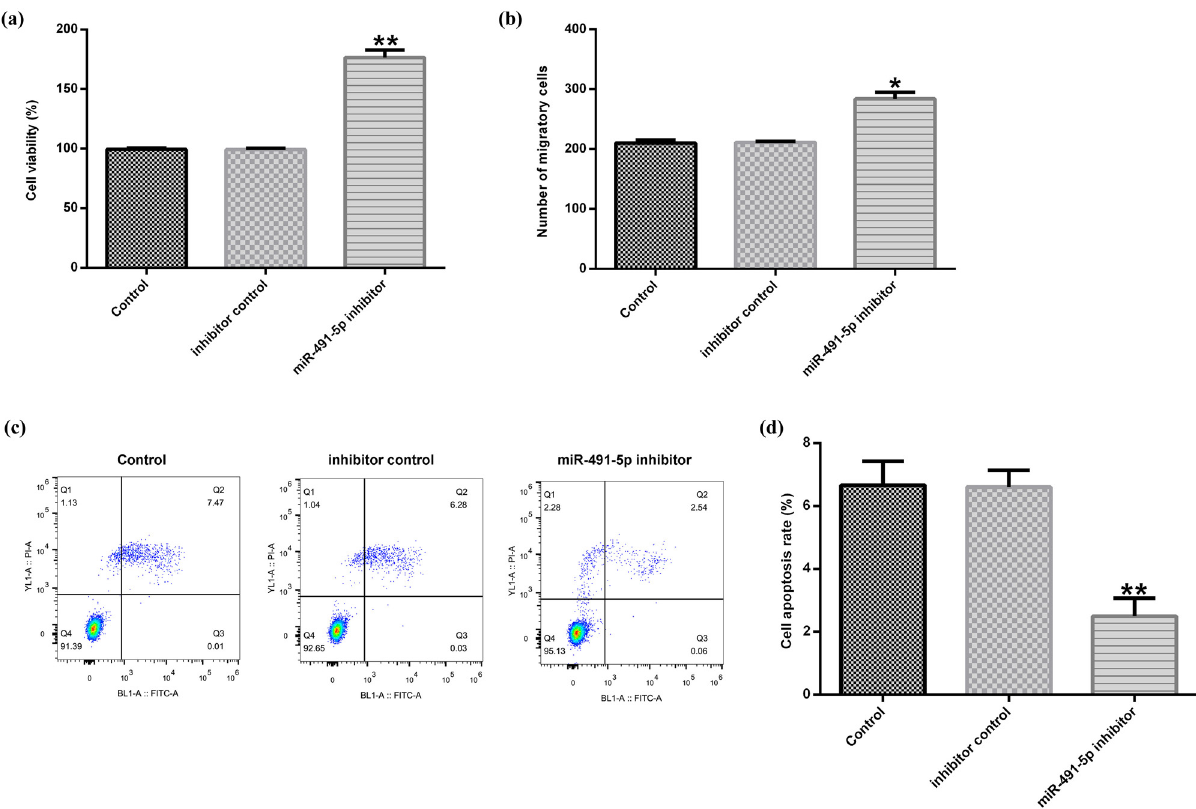
Figure 4: Downregulation of miR - 491 - 5p enhanced hVSMC viability and migration and reduced the apoptosis. The hVSMCs were pretreated with inhibitor control or miR - 491 - 5p inhibitor for 48 h. ( a ) The e ff ect of miR - 491 - 5p inhibitor on hVSMC viability was monitored by the MTT assay. ( b ) The e ff ect of miR - 491 - 5p inhibitor on hVSMC migration was determined by the transwell assay. ( c and d ) Apoptosis of hVSMCs was evaluated by the fl ow cytometric analysis. Data are shown as mean ± SD. *, ** p < 0.05, 0.01 vs.